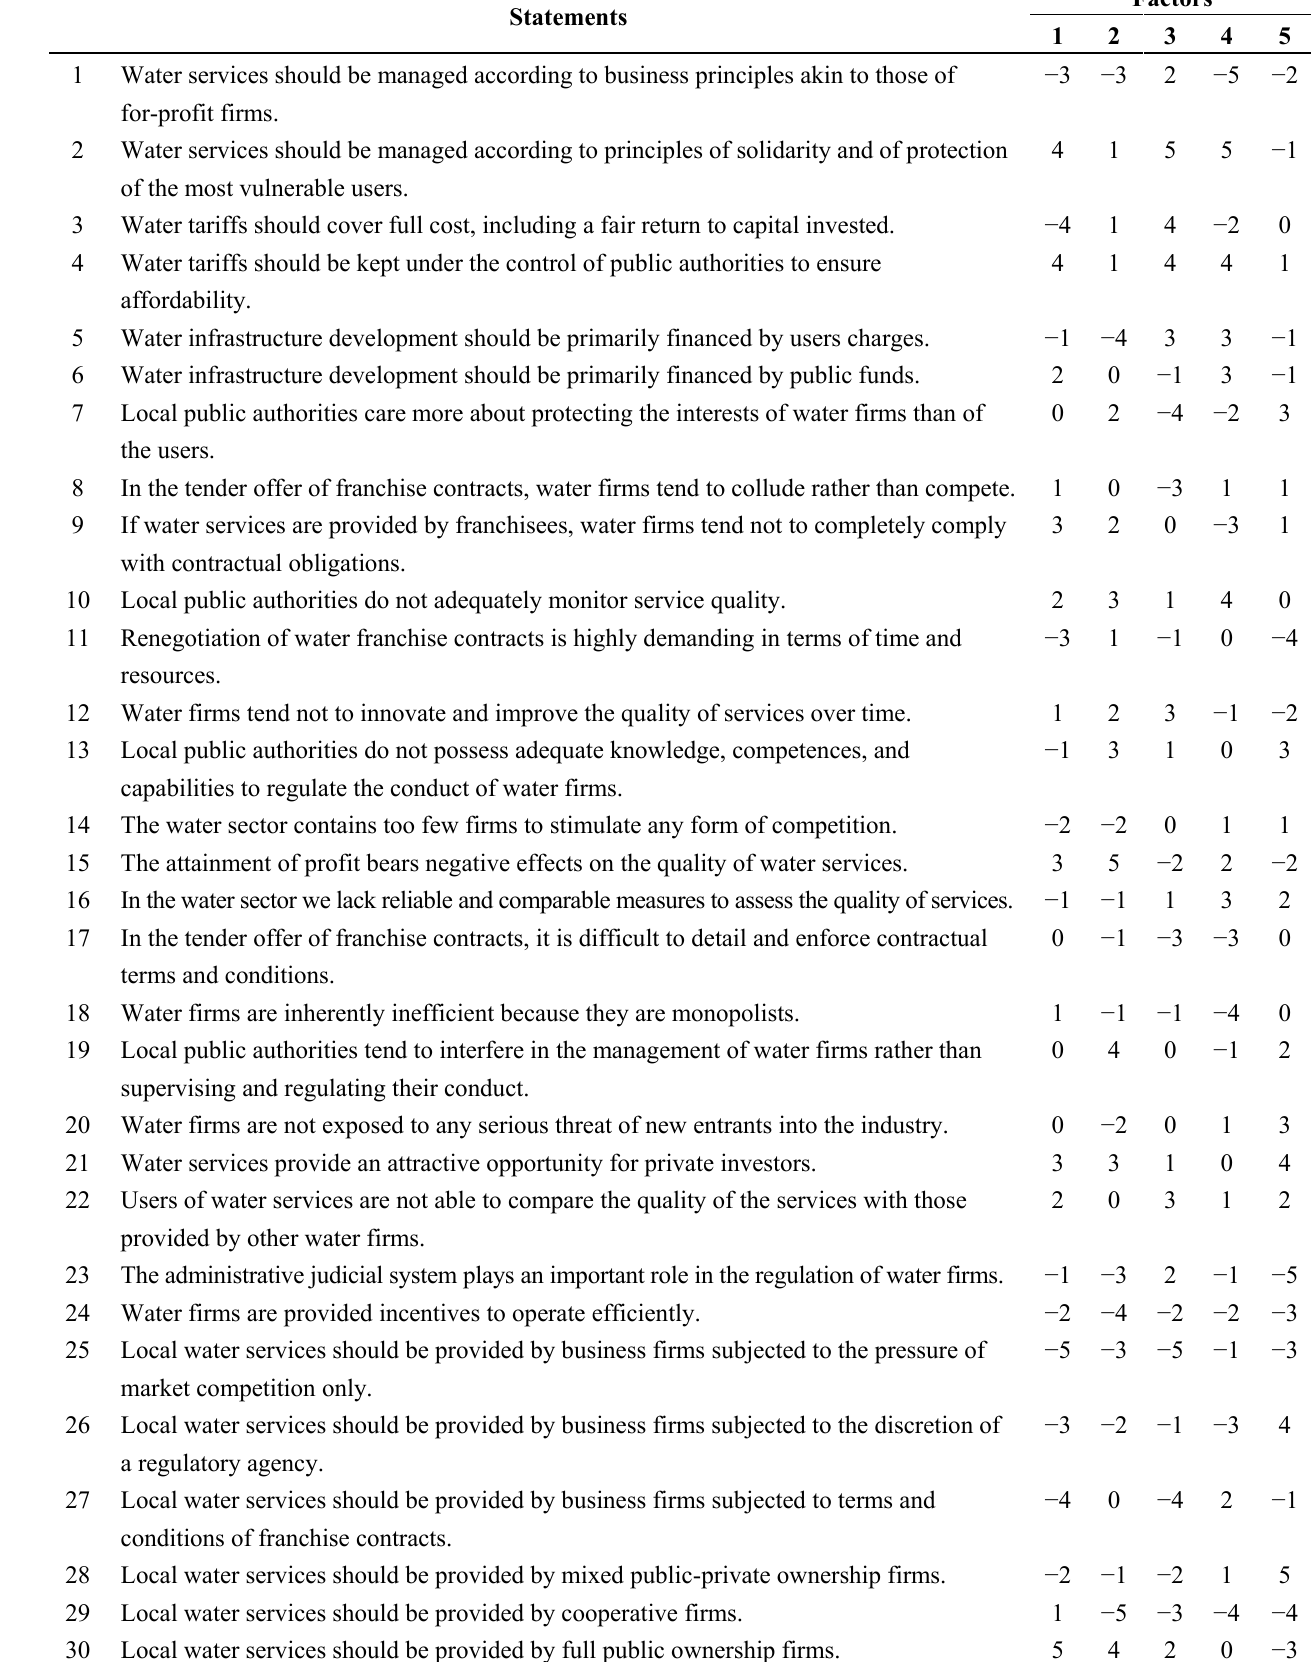
Table 4. Factor Q sort values for each